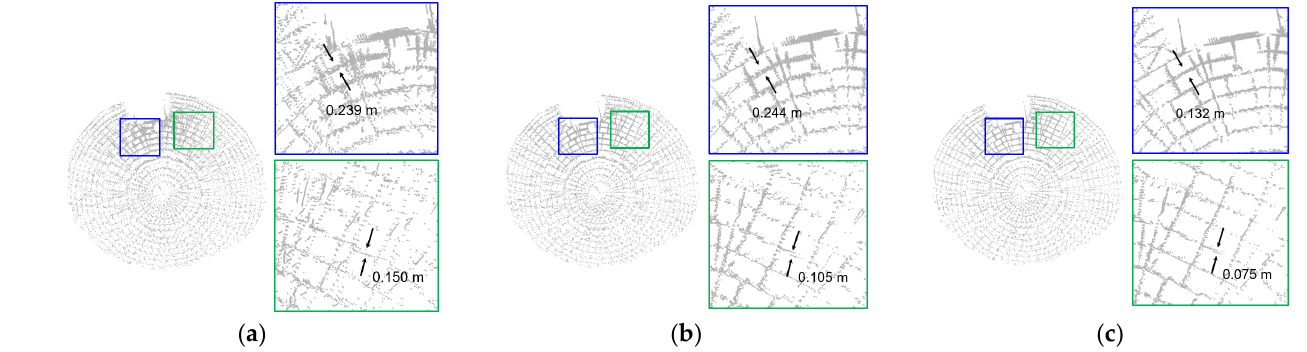
Figure 39. Extracted edge points from the scans in the Frankfort dataset showing the radial alignment of the stringer rings after the: ( a ) partial fine registration using the roof feature, ( b ) partial fine registration using the ground/wall features, and ( c ) full fine registration using the roof/ground/wall features.